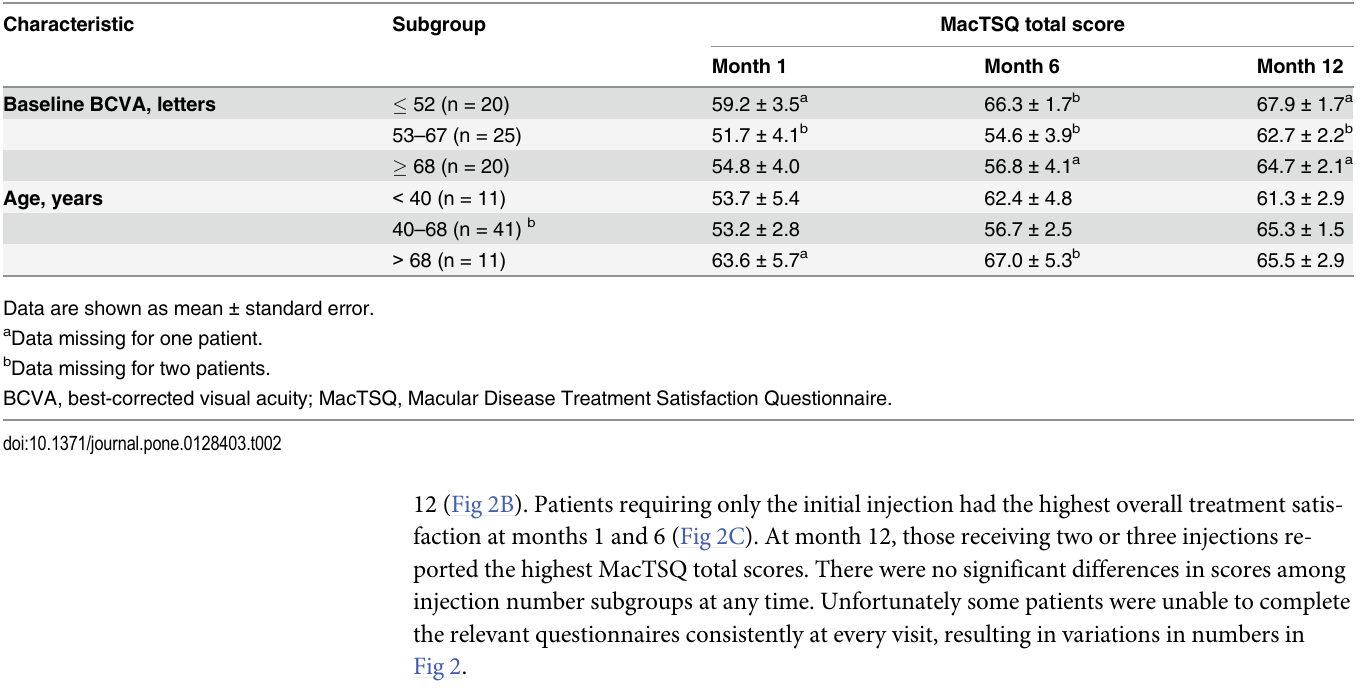
Table 2. MacTSQ results according to baseline BCVA and age. Characteristic